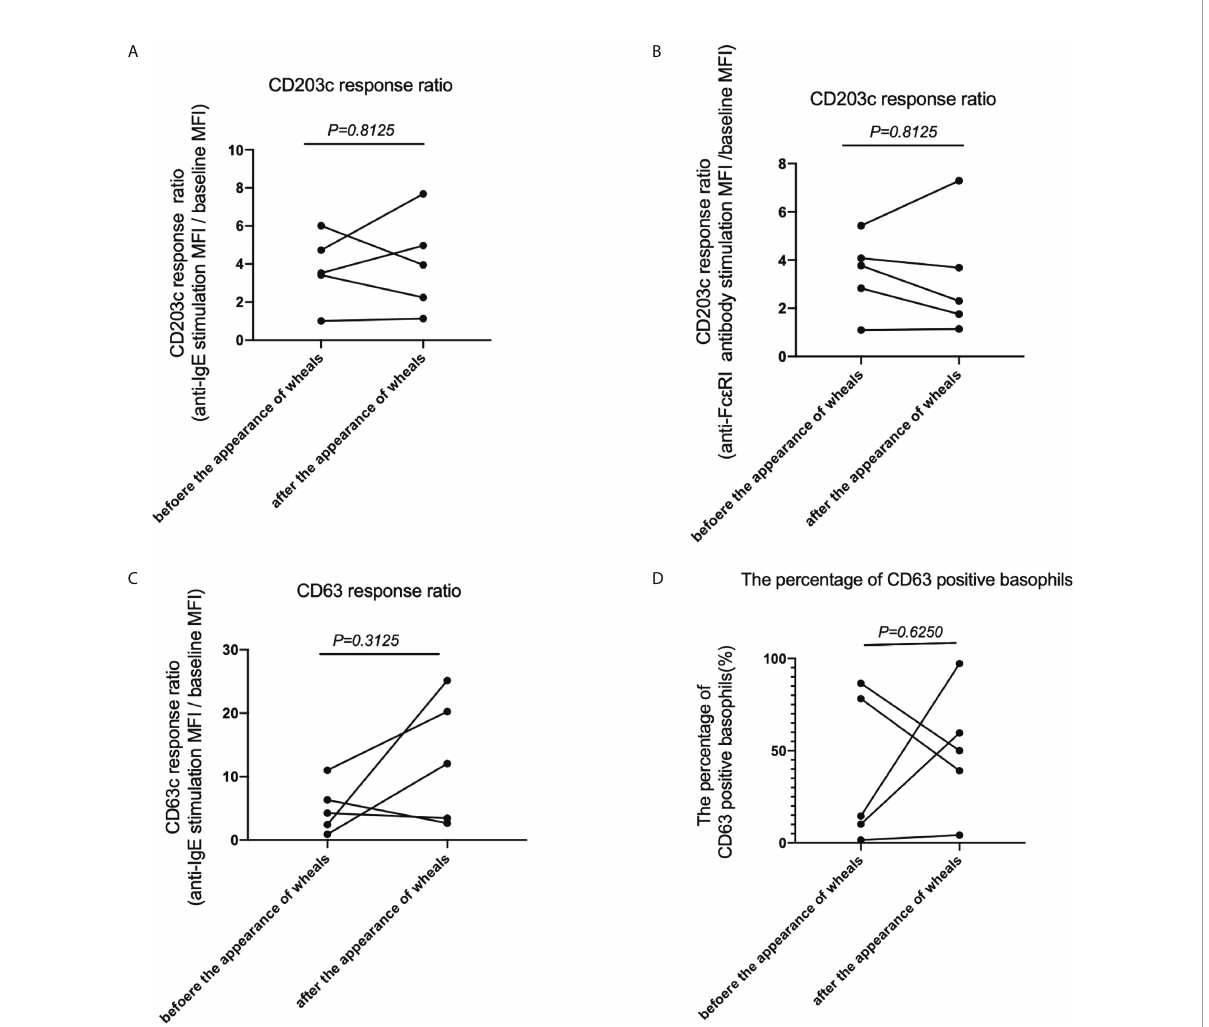
FIGURE 4 CD203c response ratio, CD63 response ratio and the percentage of CD63 positive basophils before and after the appearance of wheals in patients with CholU as a subgroup of CIndU. Comparison of CD203c response ratios of basophils when stimulated with (A) anti-IgE or (B) anti- Fc ϵ RI antibody before and after the appearance of wheals. Comparison of (C) CD63 response ratios of basophils when stimulated with anti-IgE and (D) the percentage of CD63 positive basophils when stimulated with anti-IgE before and after the appearance of wheals. Statistical analysis was performed by Wilcoxon